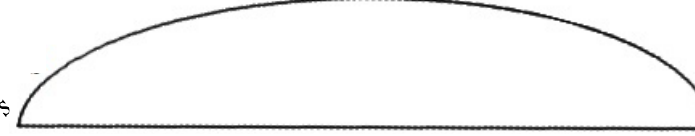
Figure 10. Intersection of the semi-ellipsoidal body and a plane passing through the length-wise symmetry axis at the bottom surface. An arc is thus defined on the body’s upper surface, where the water film thickness is computed. The curvilinear coordinate s denotes the distance from the leading edge along the upper surface.